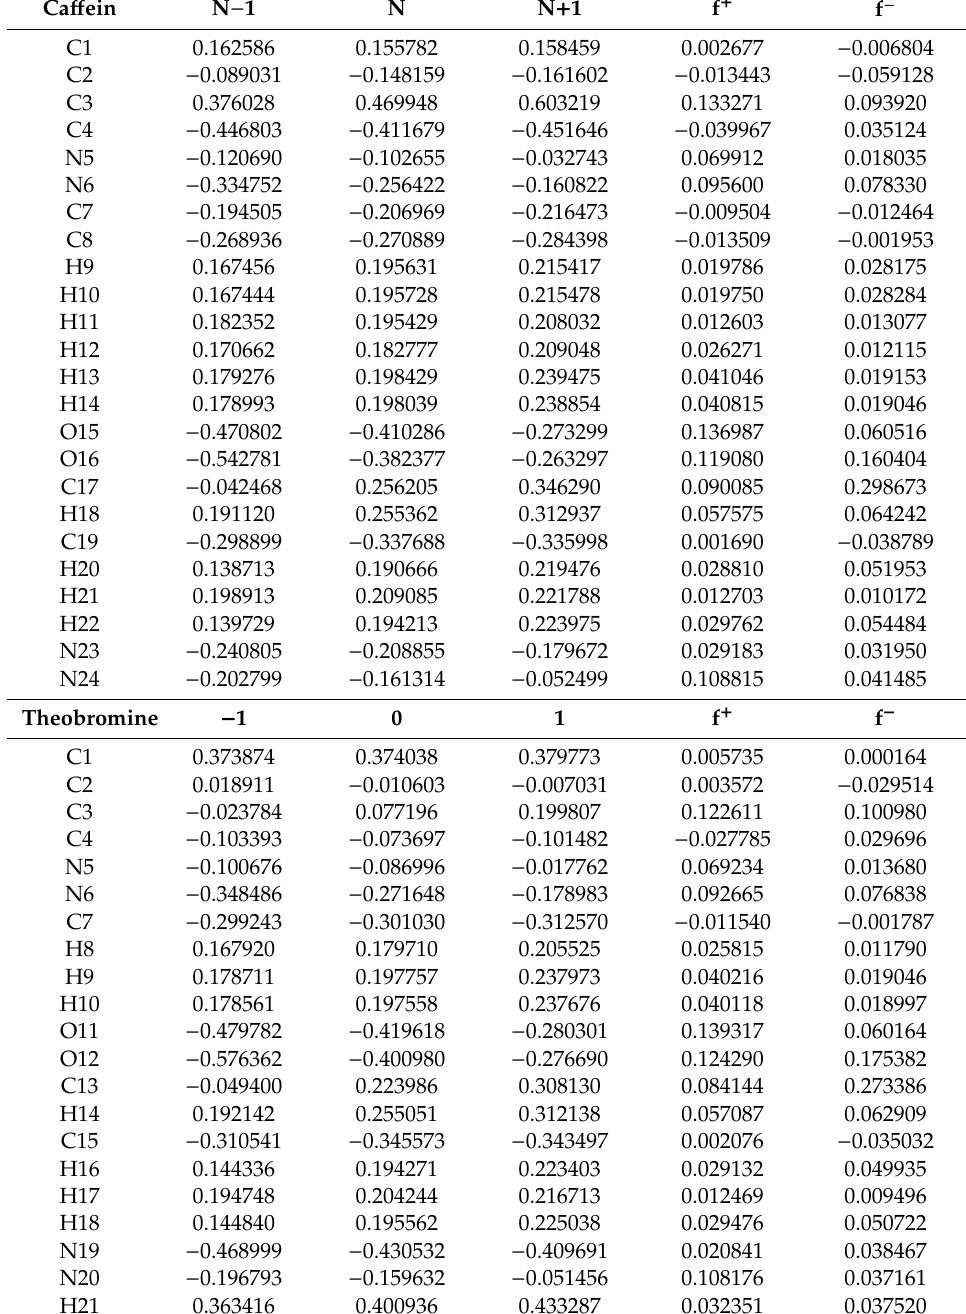
Table 6. Calculated Mulliken atomic charge distribution and Fukui indices for ca ff eine, theobromine, and theophylline in condensed phase at the B3LYP / 6-311 ++ G(dp)